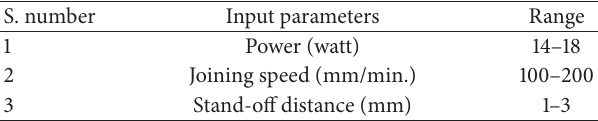
Table 2: Process parameters with their ranges. S.